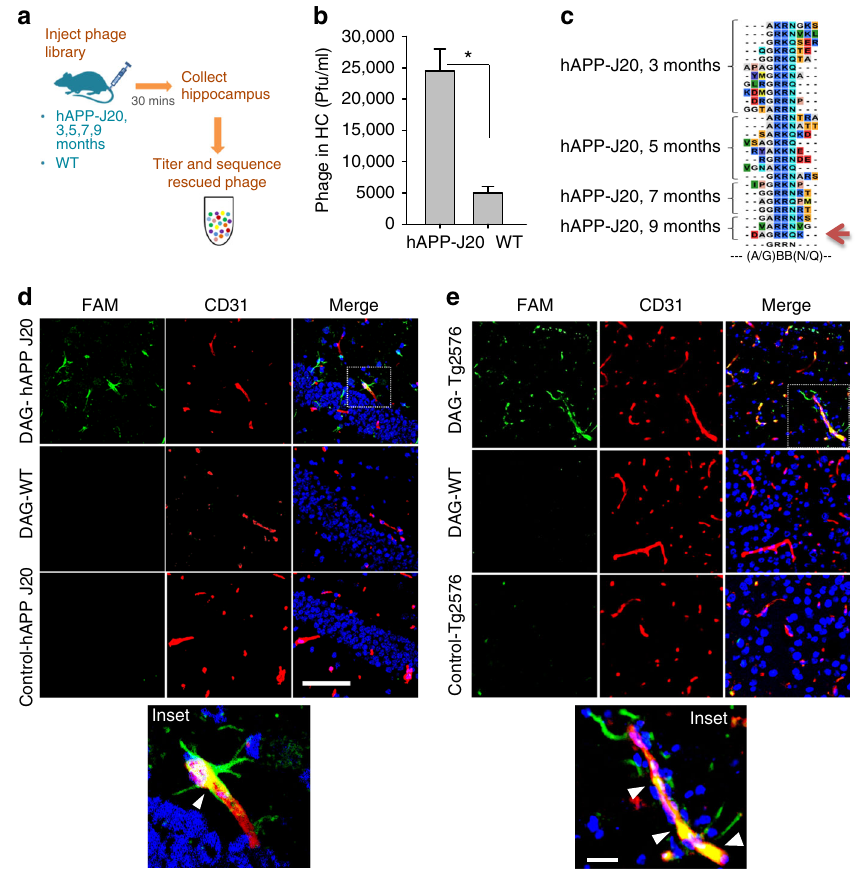
Fig. 1 Identi fi cation of DAG peptide by phage screening in transgenic mouse model of AD. Schematic representation of phage screening done in transgenic hAPP-J20 tg mice a . A CX7C library (10 9 pfu) was injected intravenously in hAPP-J20 mice and wild-type (WT) littermate controls of different ages. After 30 min of circulation and perfusion to remove unbound phage, the hippocampus was excised and phages were recovered and quanti fi ed b . The phage